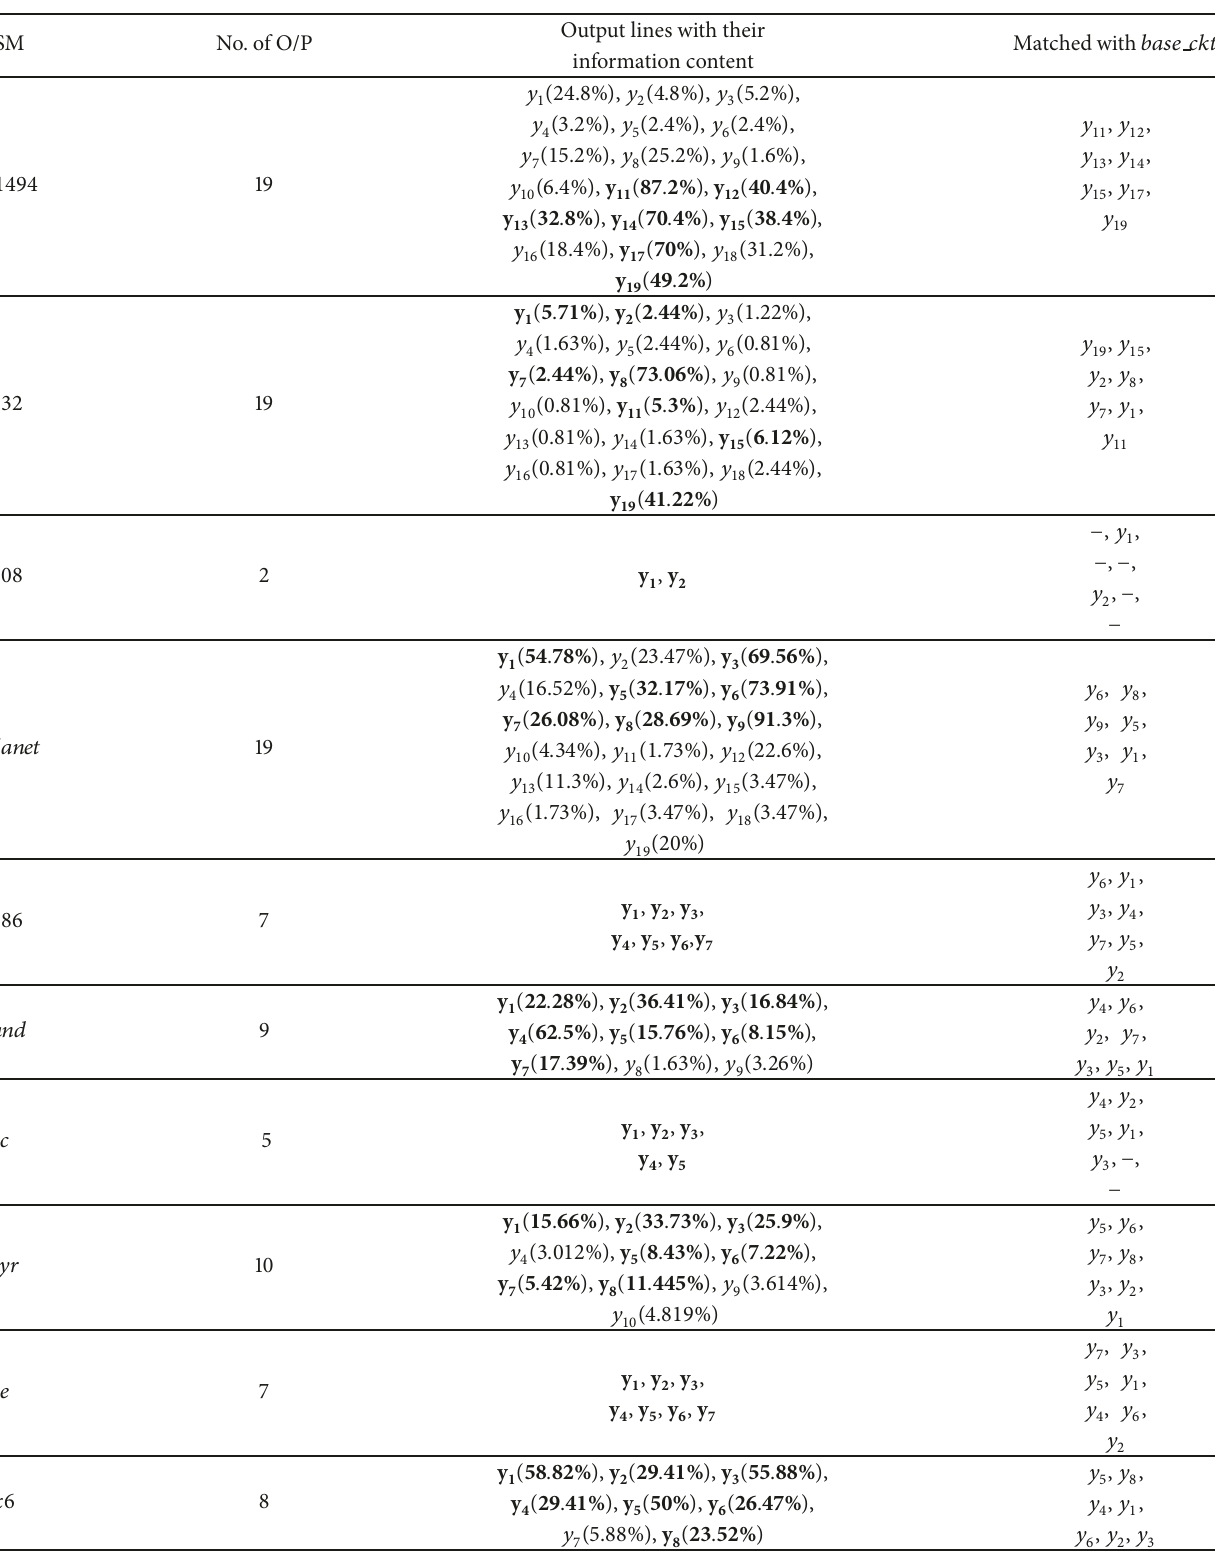
Matched with 𝑏𝑎𝑠𝑒 𝑐𝑘𝑡